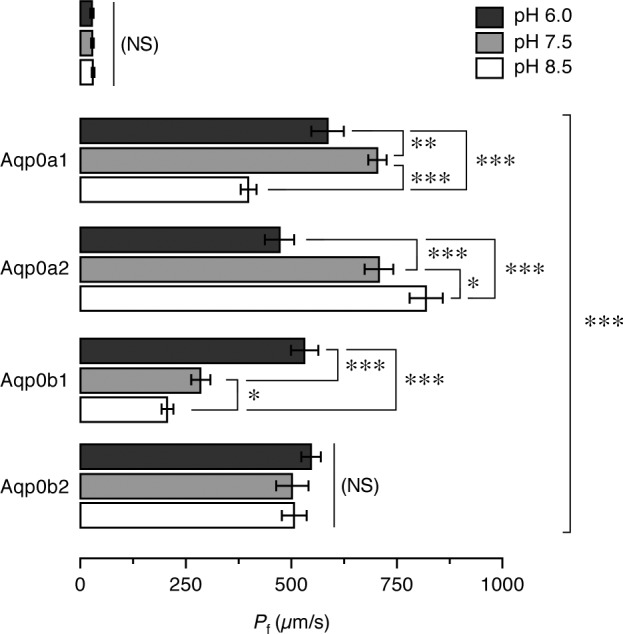
Functional characterization of Atlantic salmon Aqp0 paralogs. Osmotic water permeability (Pf) of X. laevis oocytes injected with water (W) or cRNA encoding Aqp0a1, -0a2, -0b1, and -0b2 and exposed to different pHs before and during the swelling assays. The Pf was calculated using an estimated surface area of 9× the geometric area. Data are the mean ± sem (n = 12 oocytes per treatment) of 3 independent experiments. Significant differences (*P < 0.05; **P < 0.01; ***P < 0.001) for each aquaporin at the 3 pHs are indicated. The bracket indicates significant differences with respect water-injected oocytes. NS, not significant.